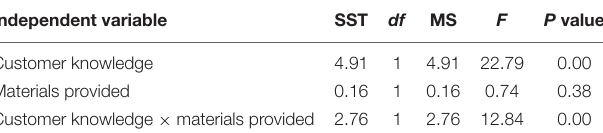
TABLE 8 | Customer knowledge, materials provided, and their interactions.